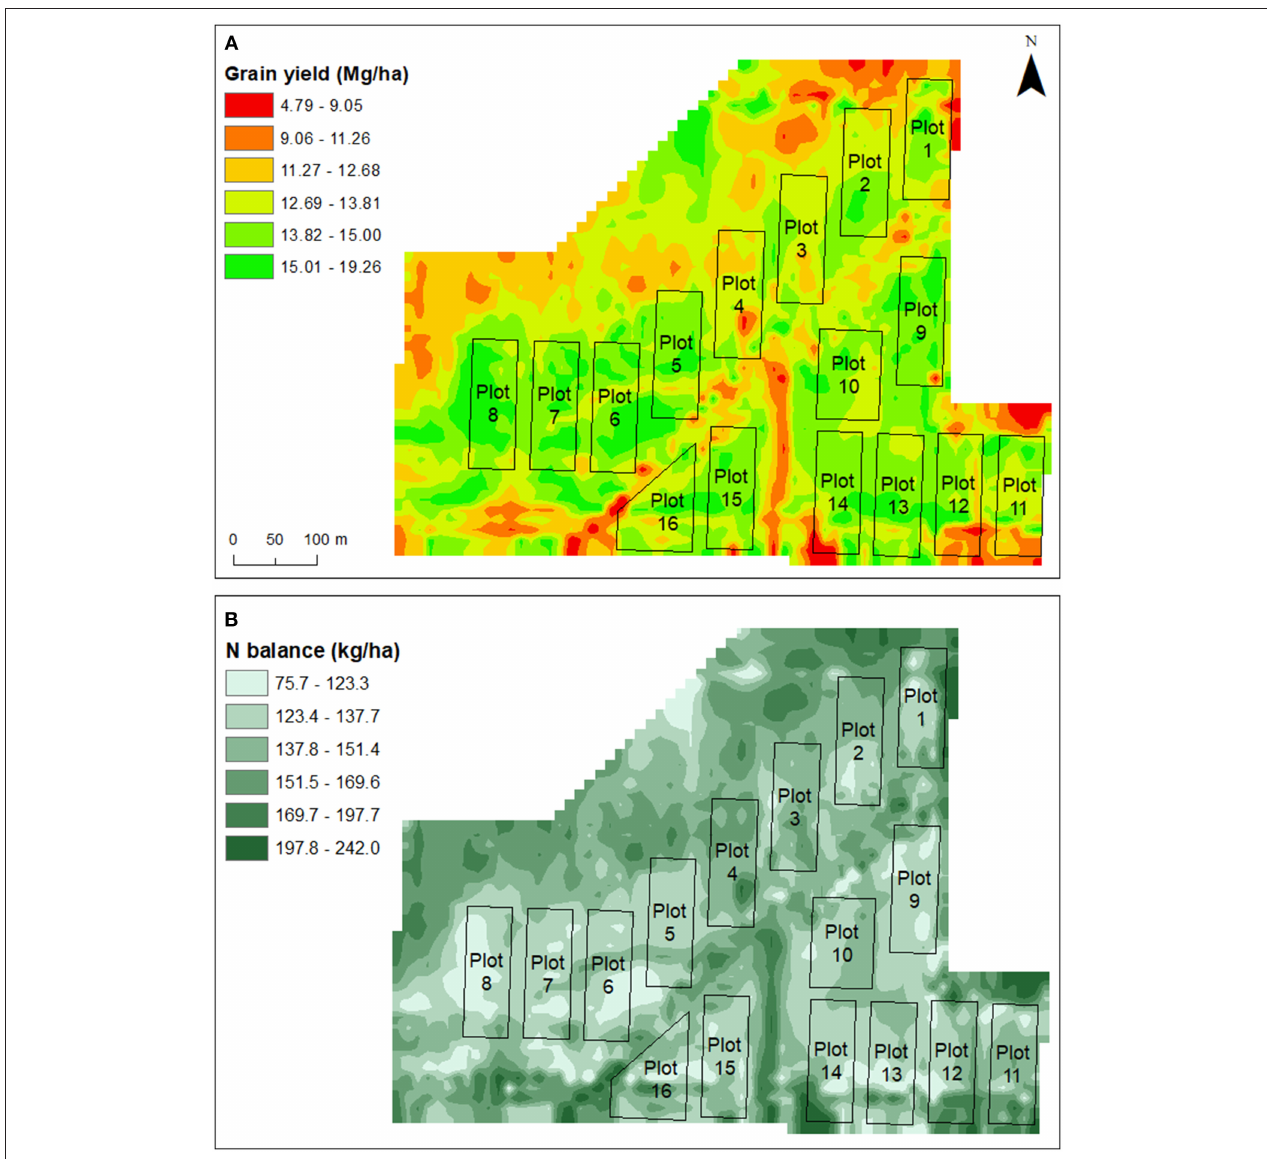
FIGURE 6 | Corn grain yield (A) and nitrogen (N) balance (B) at the end of the 2017 growing season.